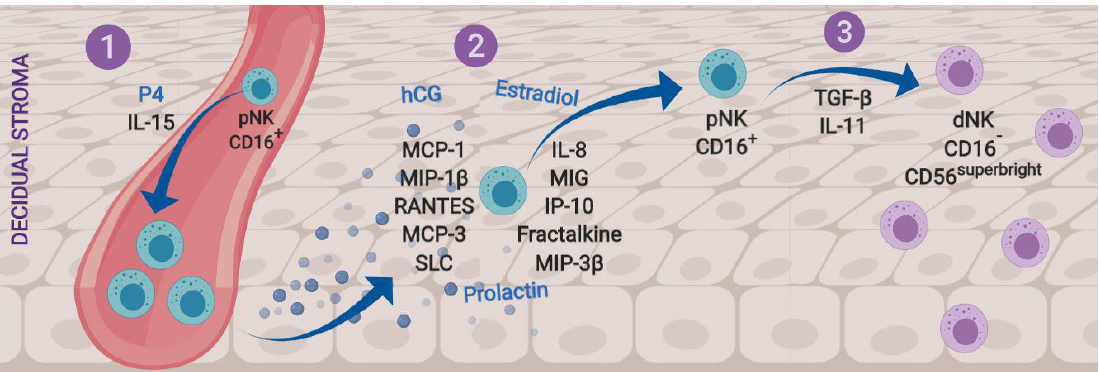
Figure 1. Stages of recruitment and differentiation of decidual natural killer (NK) cells. (1) Progesterone (P4) and interleukin (IL)-15 induce pNK cell proliferation. (2) Chemotactic factors produced by trophoblasts, endothelium and decidual epithelium selectively recruit pNK cells into the implantation site. (3) The endometrial environment, characterized by high levels of transforming growth factor beta (TGF-β) and IL-11, induces the differentiation of pNK cells to dNK cells, with the less cytotoxic phenotype CD16 - and CD56 superbright . dNK = decidual natural killer cell; pNK = peripheral natural killer cell.